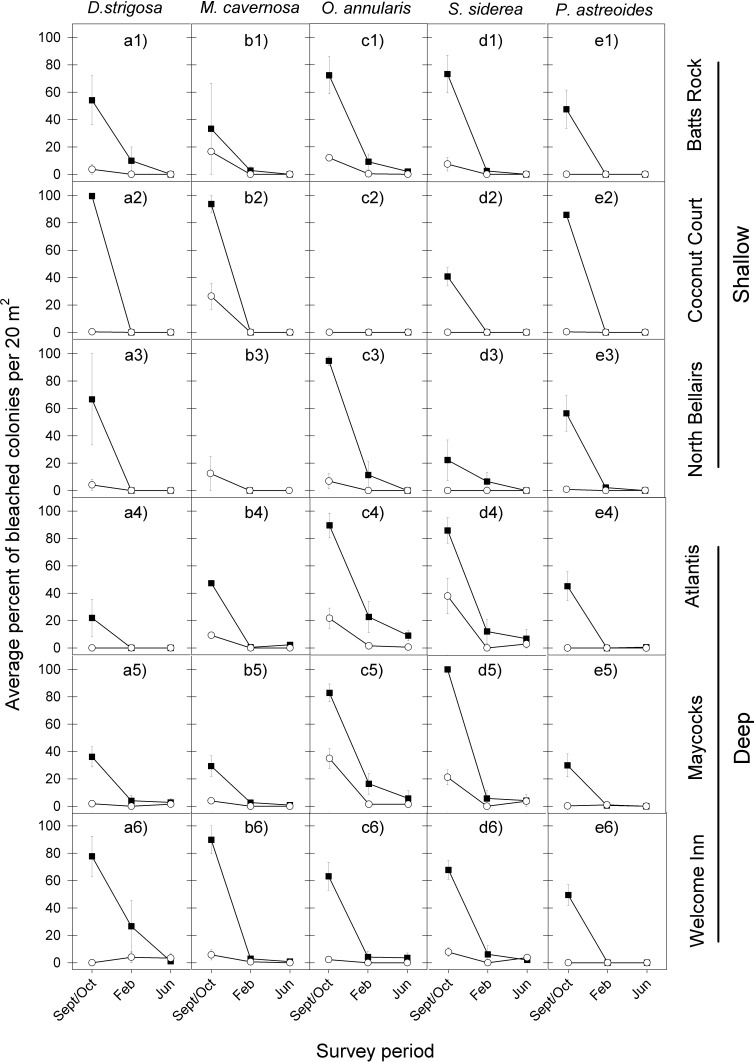
Average percent of bleached colonies during peak bleaching (September/October) and the following post-bleaching (February and June) survey periods in 2005–2006 (black squares) and 2010–2011 (white circles) for the five selected dominant coral species (A–E) across the six study sites (1–6).Error bars denote 1 standard error. Lack of symbols in b3 panel indicates that no M. cavernosa colonies were sampled in Sept/Oct 2005 and in June 2006 at the North Bellairs site; and in c2 panel no O. annularis colonies were sampled in Sept/Oct 2005 at the Coconut Court site.